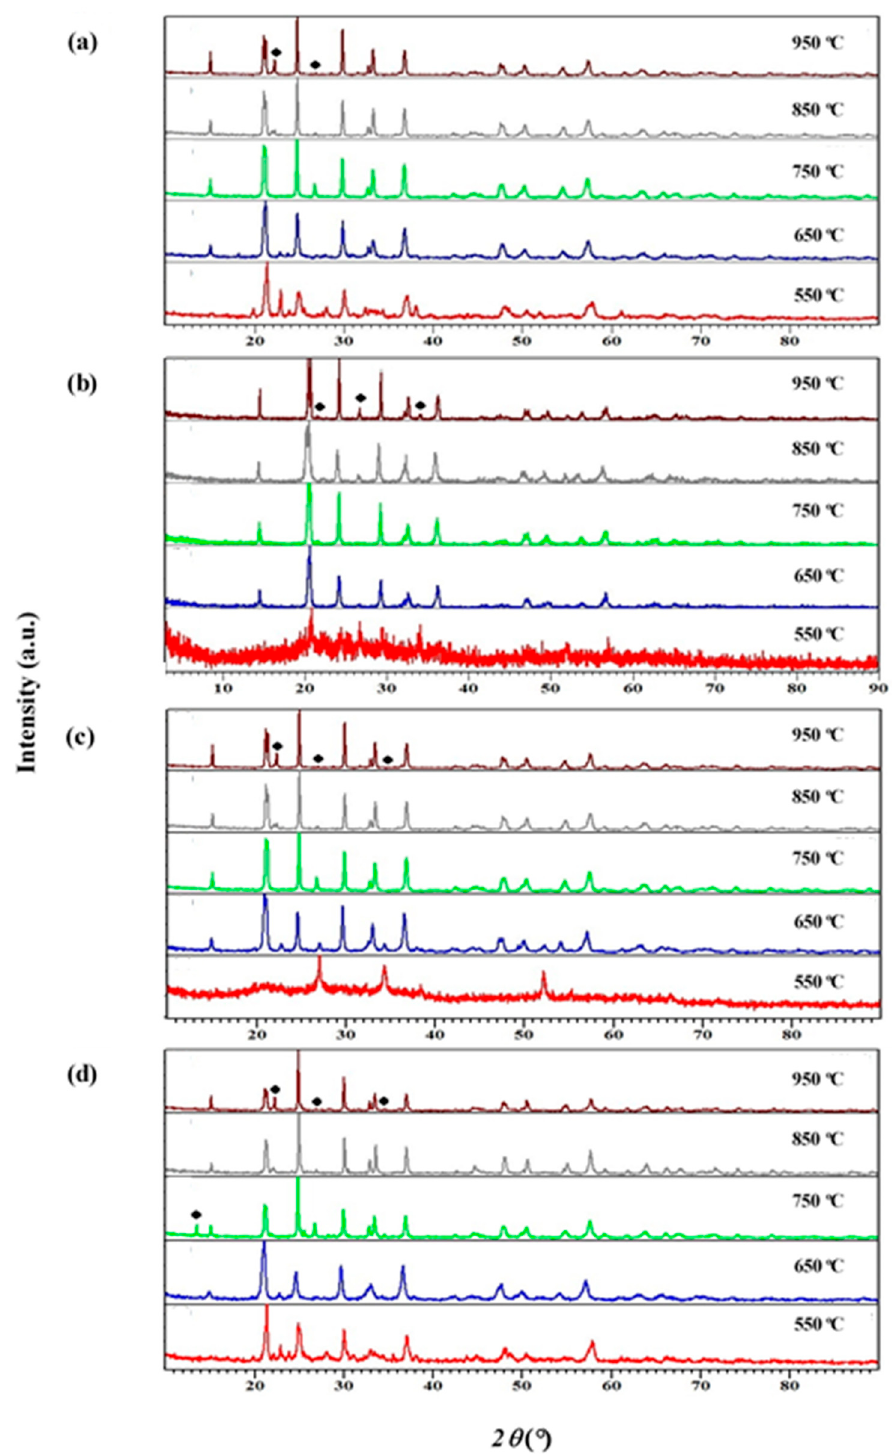
Figure 1. XRD diffractograms of Li 1+x Al x Ti x Sn 2 − x P 3 O 12 with x = ( a ) 0.2, ( b ) 0.4, ( c ) 0.6 and ( d ) 0.8 sintered at various sintering temperatures. The impurity peak of AlPO 3 is marked as ♦ . The samples sintered at 850 ◦ C show almost pure samples with low impurity for all stoichiometries. However, the impurity peak of the AlPO 3 phase is also observed in most samples. The impurity peaks are more obvious for the samples with x = 0.8. For the rest, the impurity peak to the signal ratio is quite low. It is attributed to a high amount of substituent, which causes Al 3+ ions to react with PO 3 − ions due to the strength of